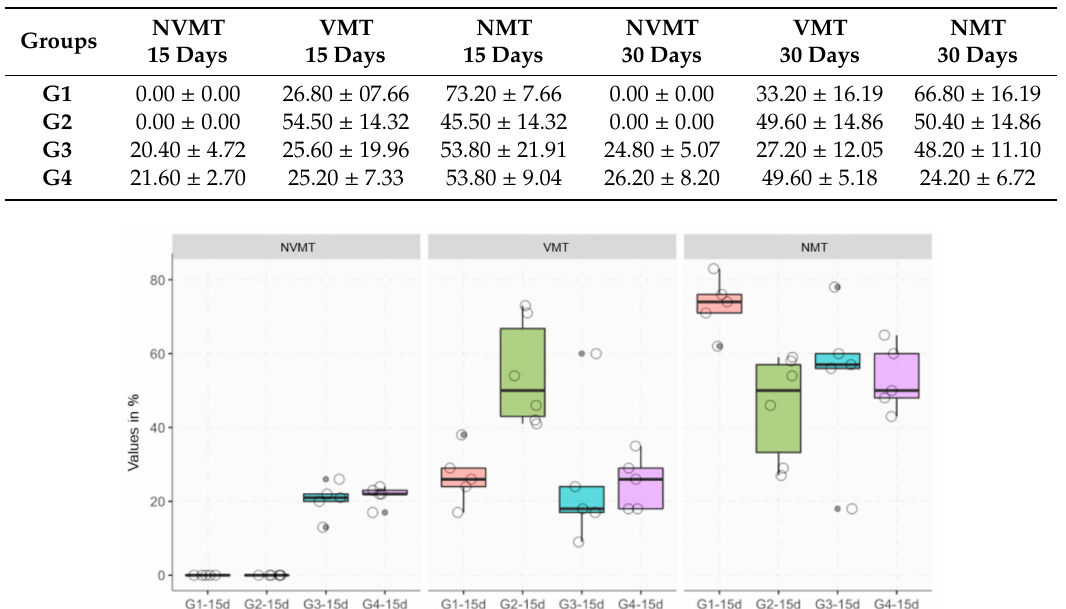
Table 1. Representation of the descriptive statistics of the analyzed parameters NVMT (Non-vital